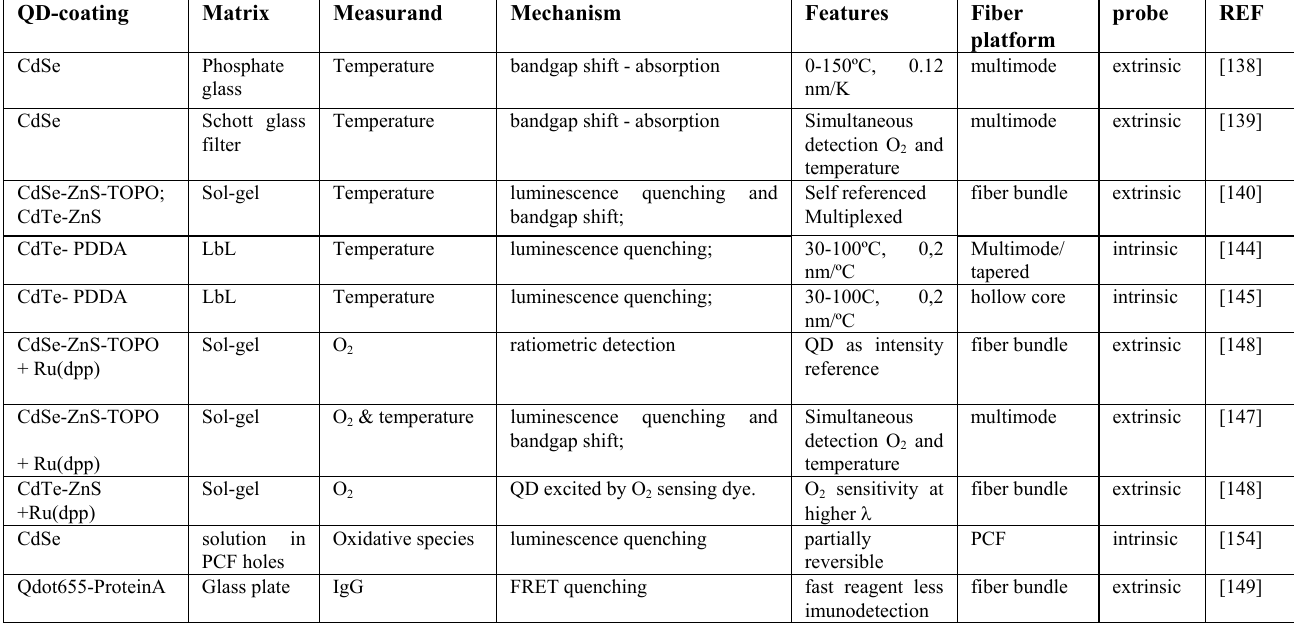
Table 2. – QD applications in optical fiber